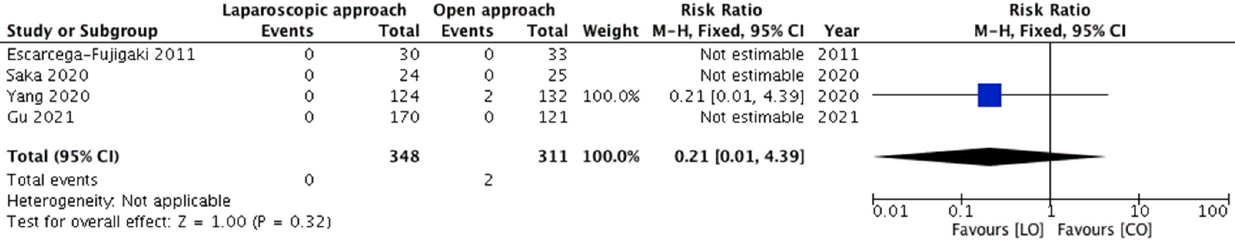
Figure 5. Forest plot comparison between the two treatment groups for the need for redo-orchiopexy after excluding the children with peeping testes.